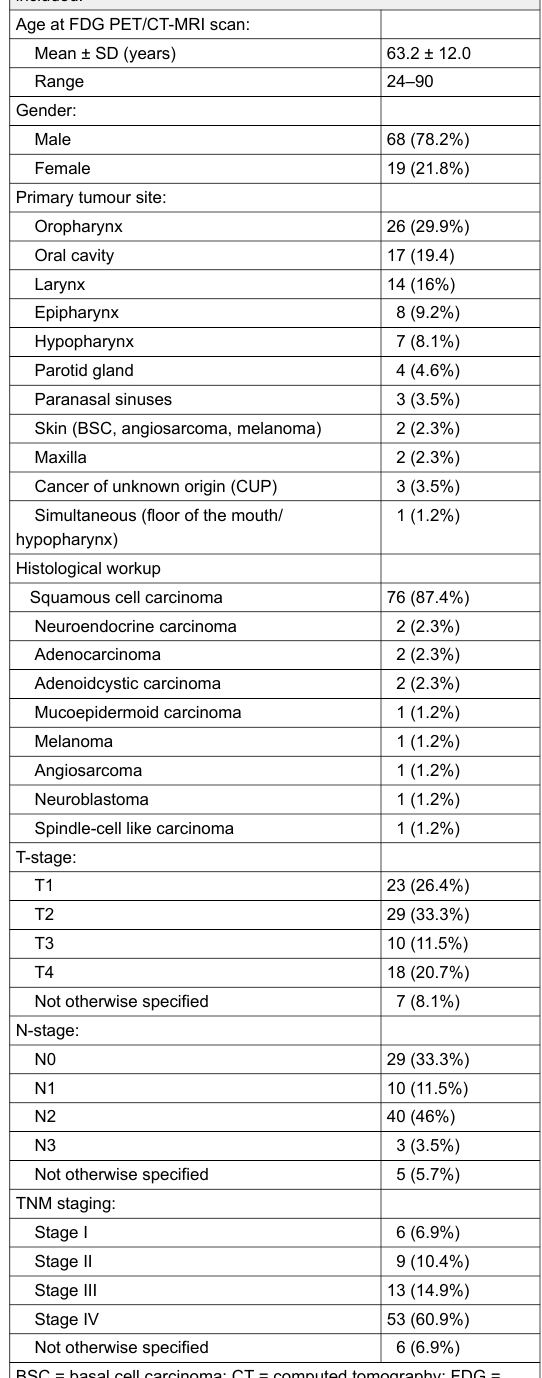
Table 1: Patient and tumour characteristics for all 87 patients